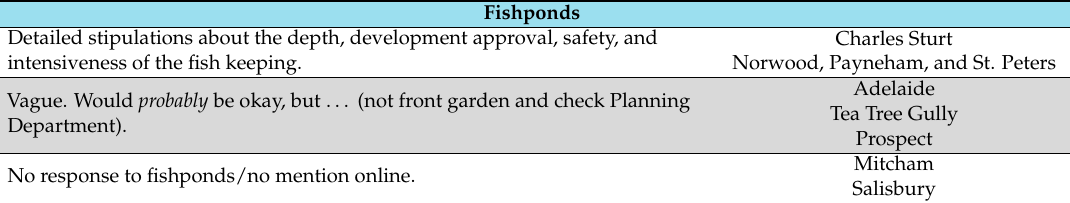
Table 3. Scenario analysis results relating to aquaponics: having a fishpond, having an aquaponics system at a community garden, and running a small home businesses selling home-grown